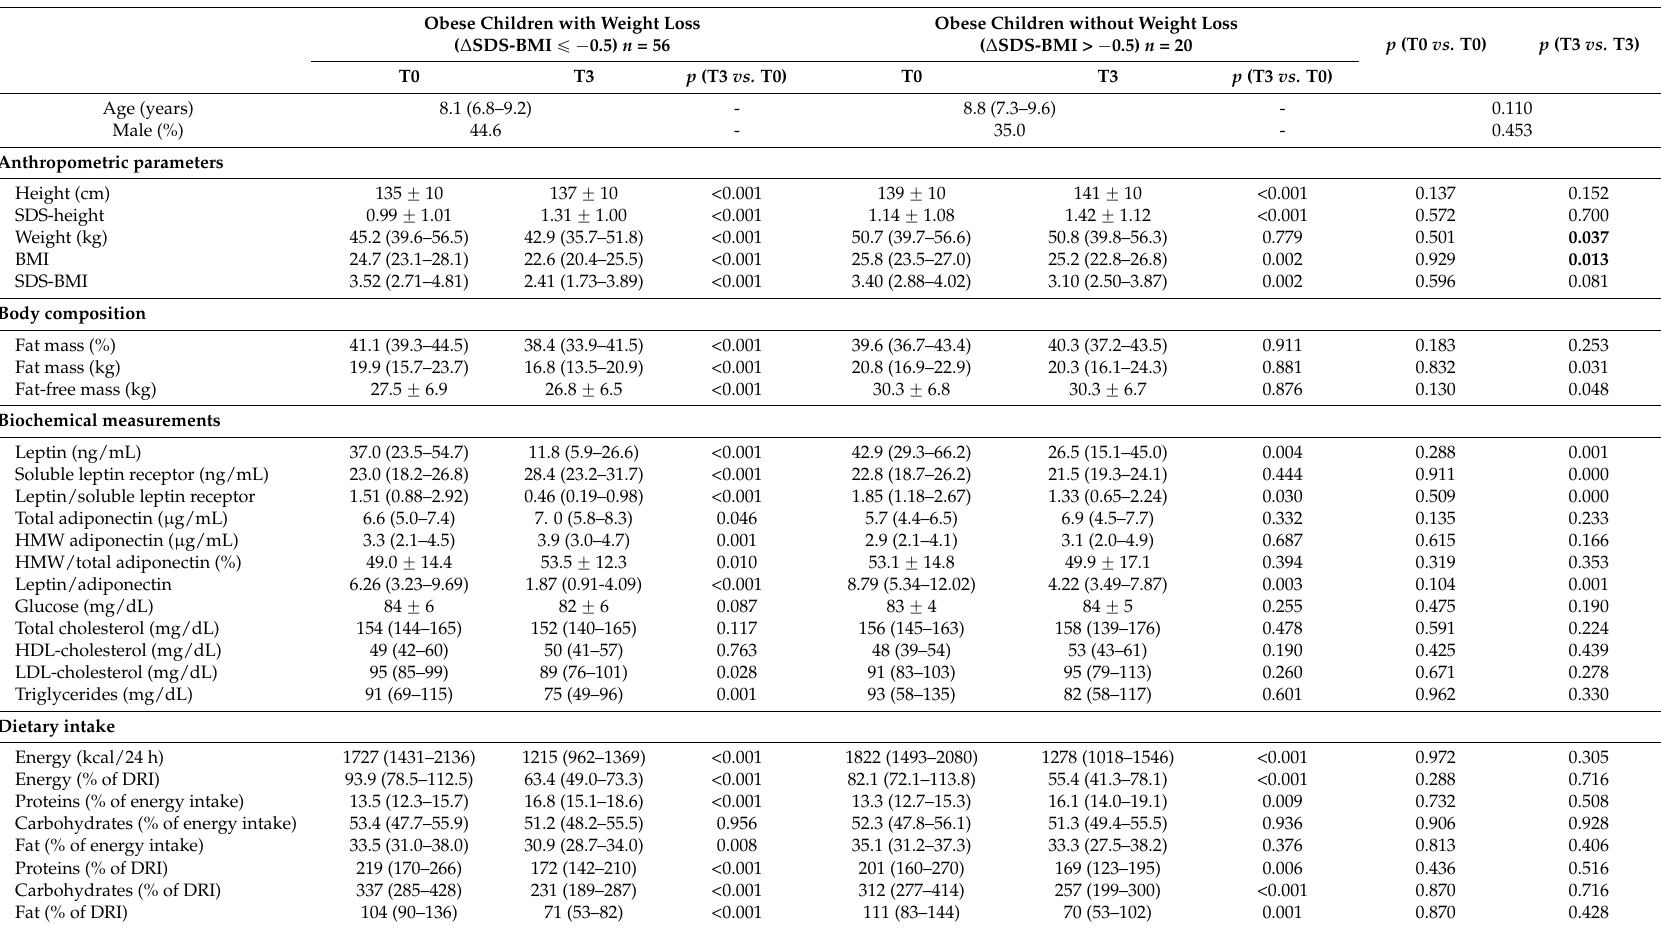
Table 4. Clinical and biochemical characteristics and dietary intake in prepubertal obese children with and without weight